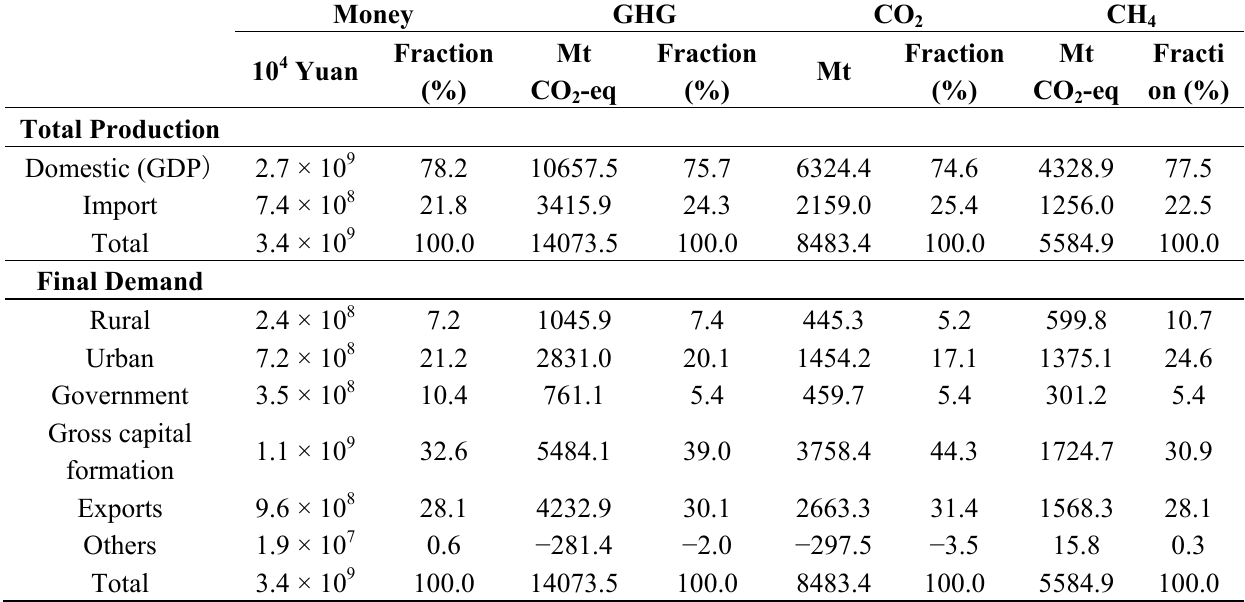
Table 4. Economy-wide balance of monetary and emission flows.